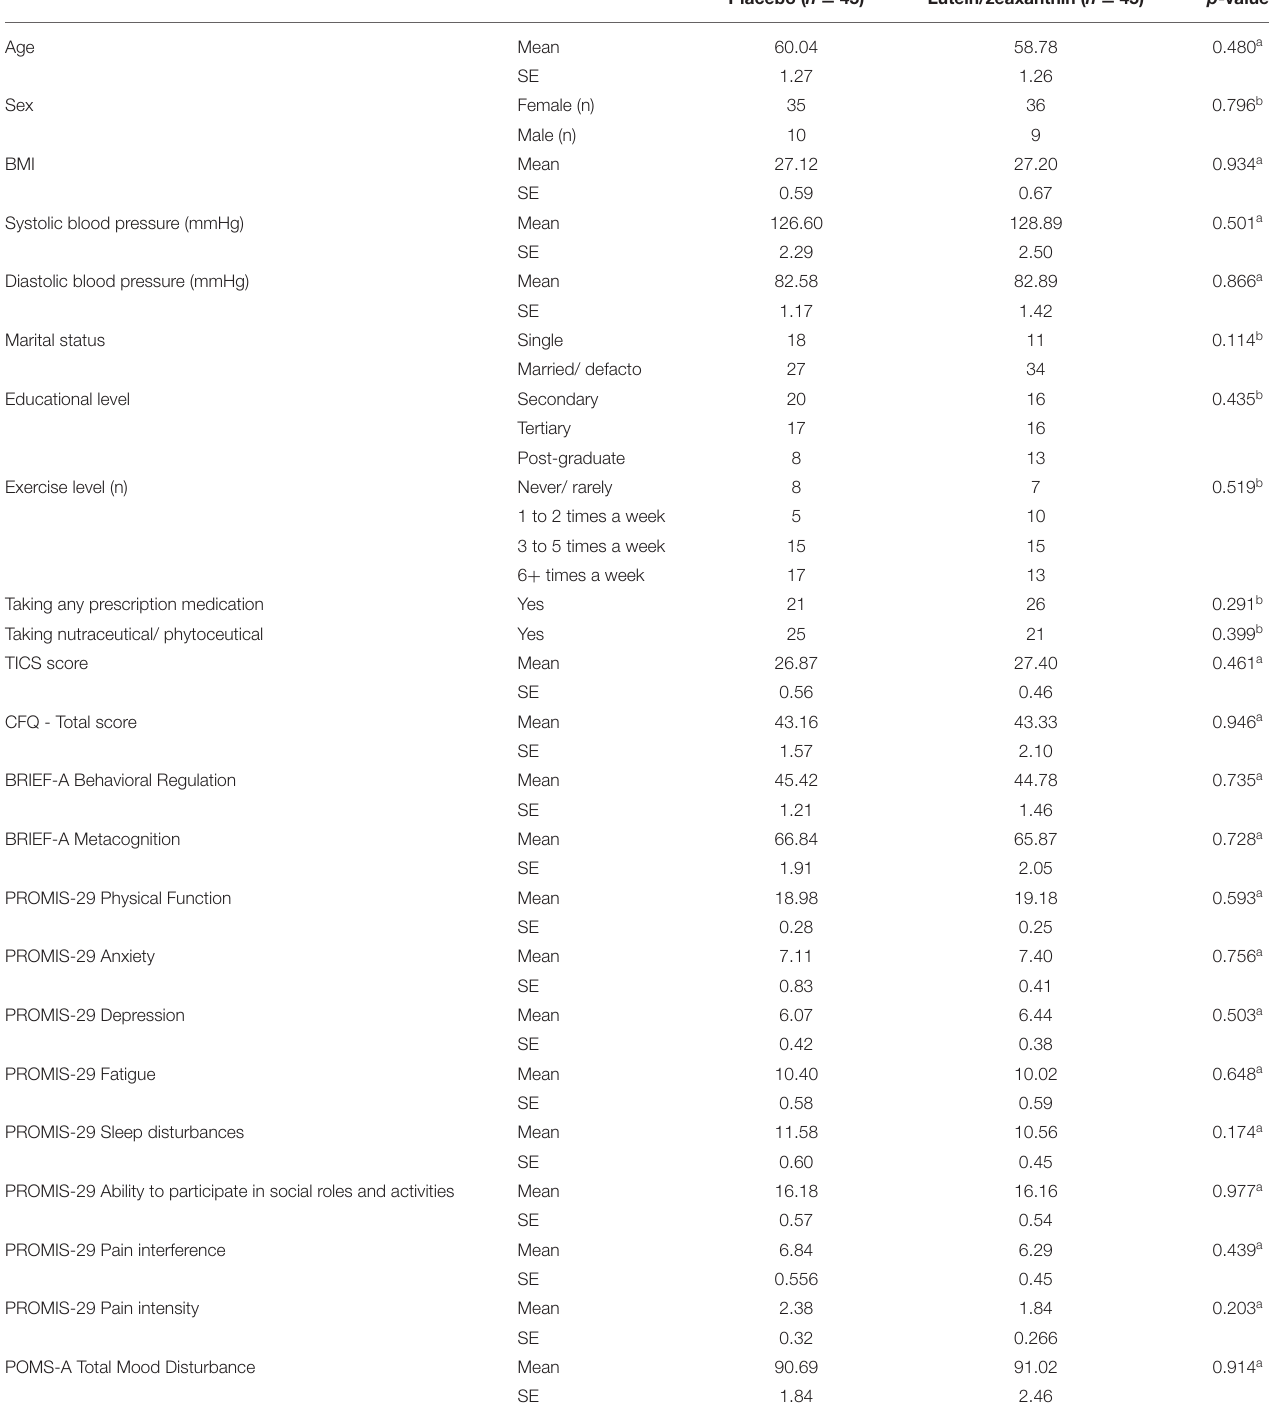
TABLE 2 | Baseline demographics details and questionnaire